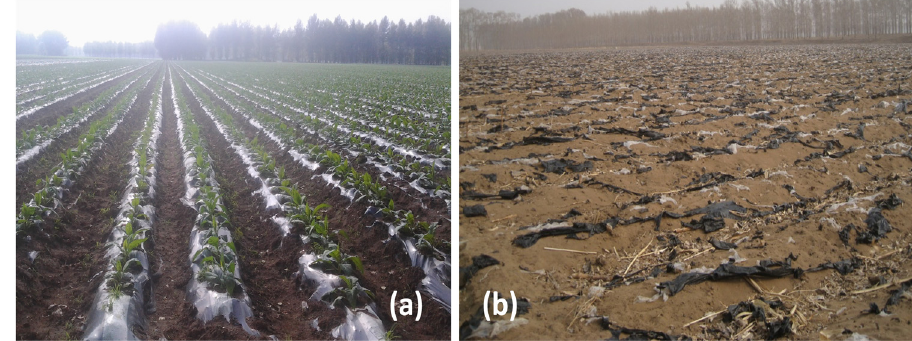
Figure 1: Plastic fi lm mulched tobacco ( a ) and fi lm residues ( b ) in fi eld surface of